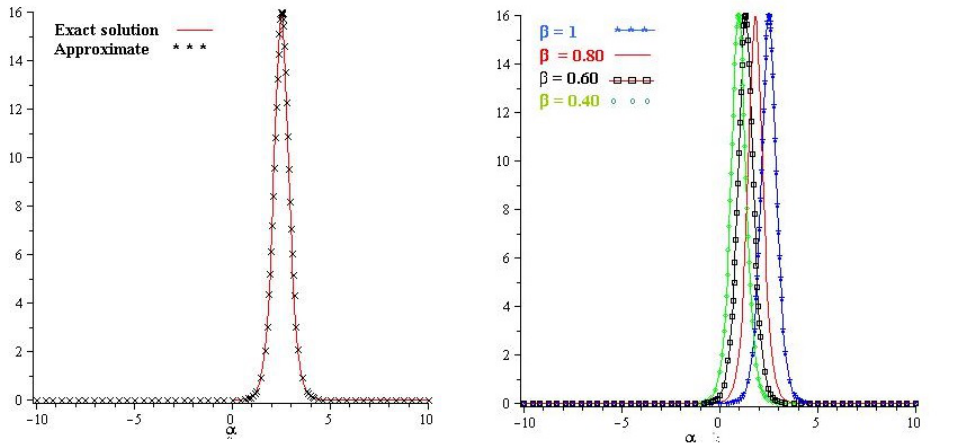
Figure 4. Exact and NDM solution of ν ( α , η ) at different fractional order δ = 1,0.8,0.6,0.4, and η =